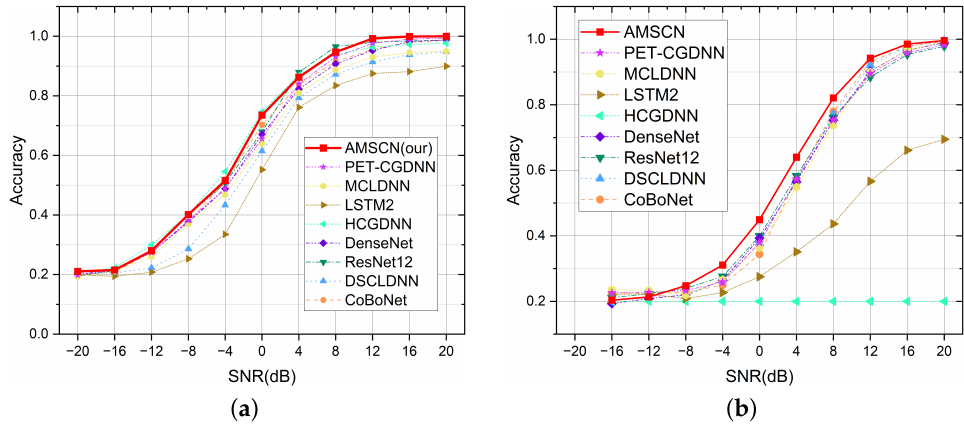
Figure 10. Performance comparison between the AMSCN and other popular models. ( a ) Model performance curves in the AMC tasks. ( b ) Model performance curves in the SEI tasks. Table 4. The average accuracy comparison between the AMSCN and other popular models.